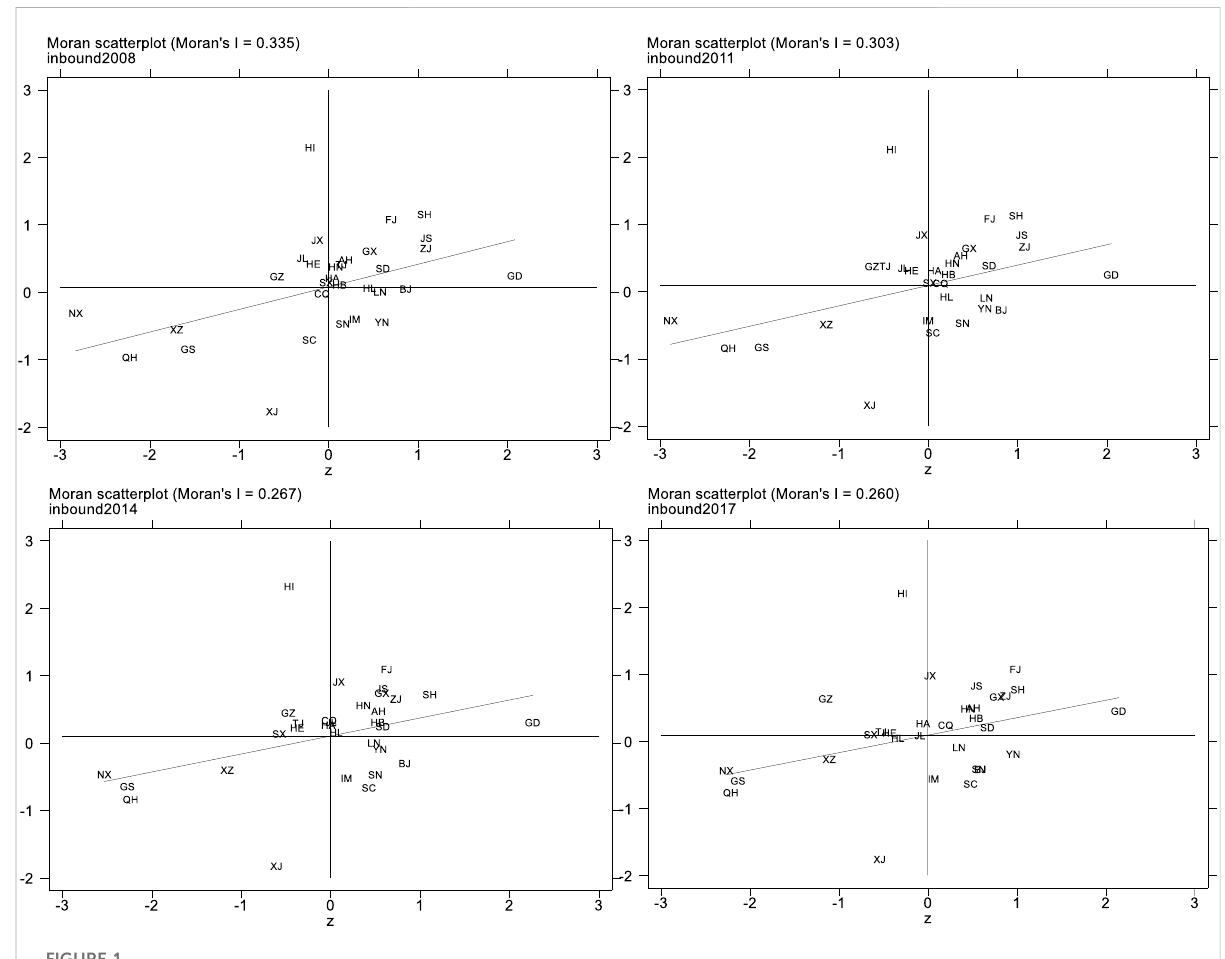
FIGURE 1 Moran scatter plot of inbound overnight tourists from 31 provinces in China in 2008, 2011, 2014, and